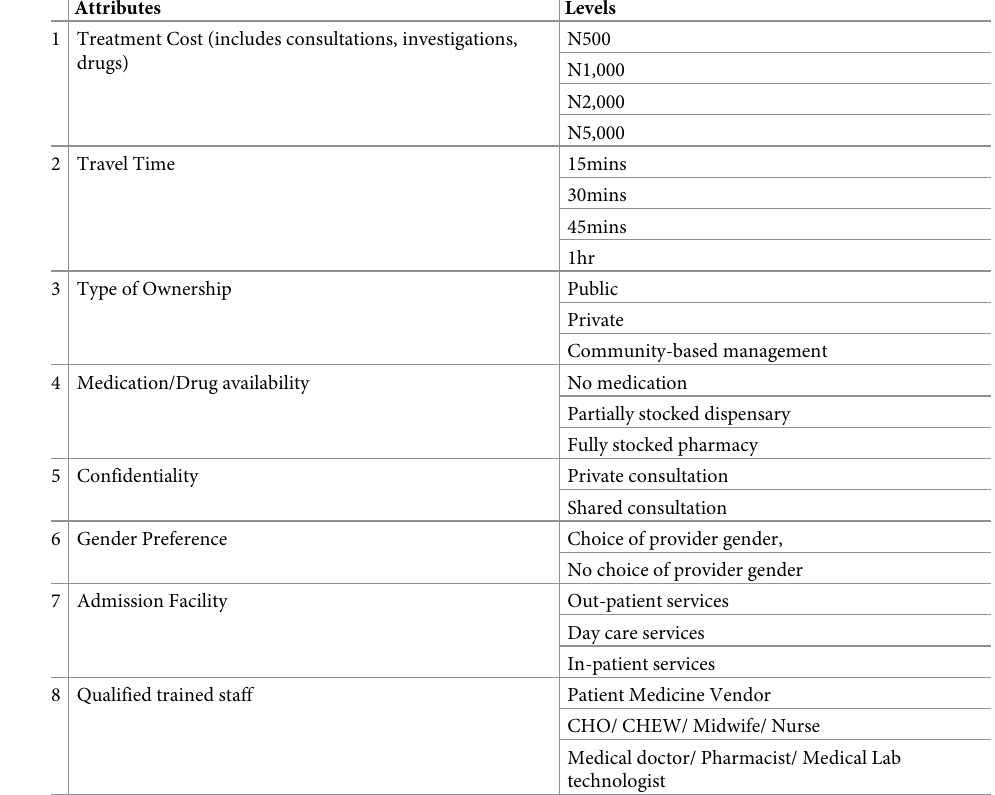
Table 1. Attributes and levels chosen for the discrete choice experiment.